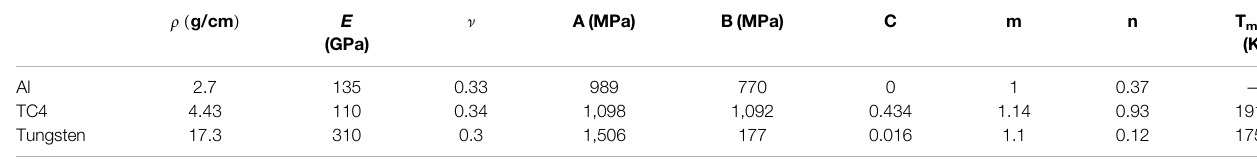
TABLE 1 | Tungsten alloy, TC4, and Al material parameters.